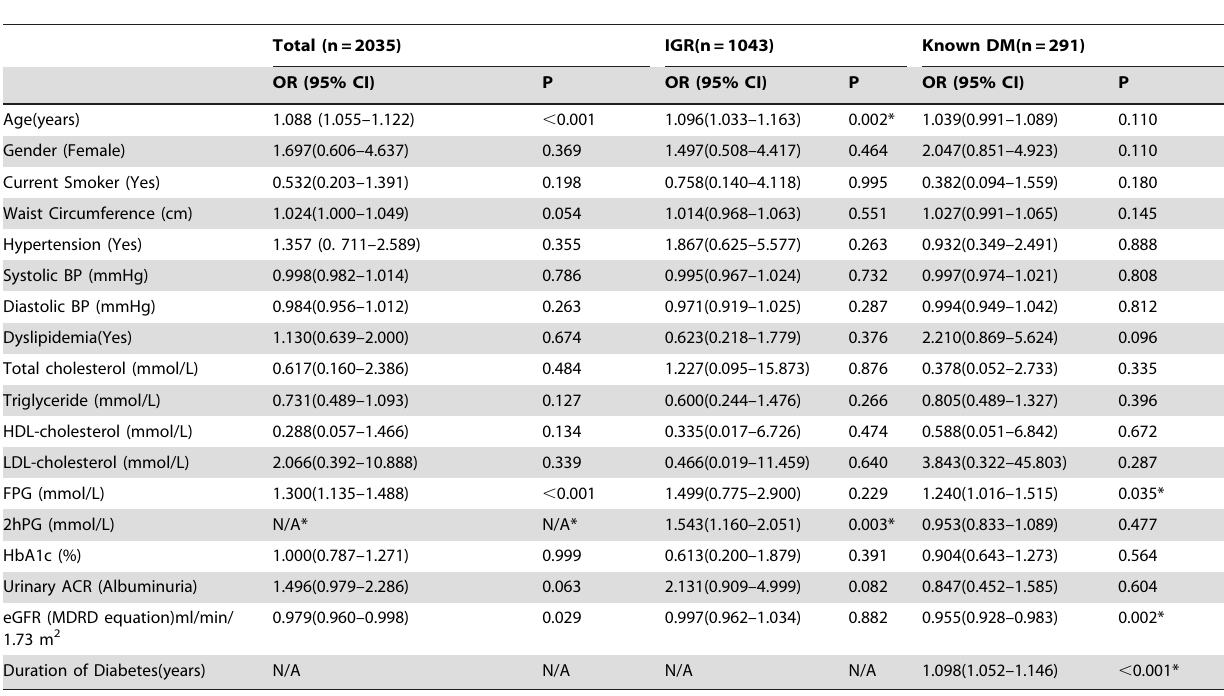
Table 4. Multiple logistic regression analysis using PN as a dependent variable among the NGT, IGR and DM